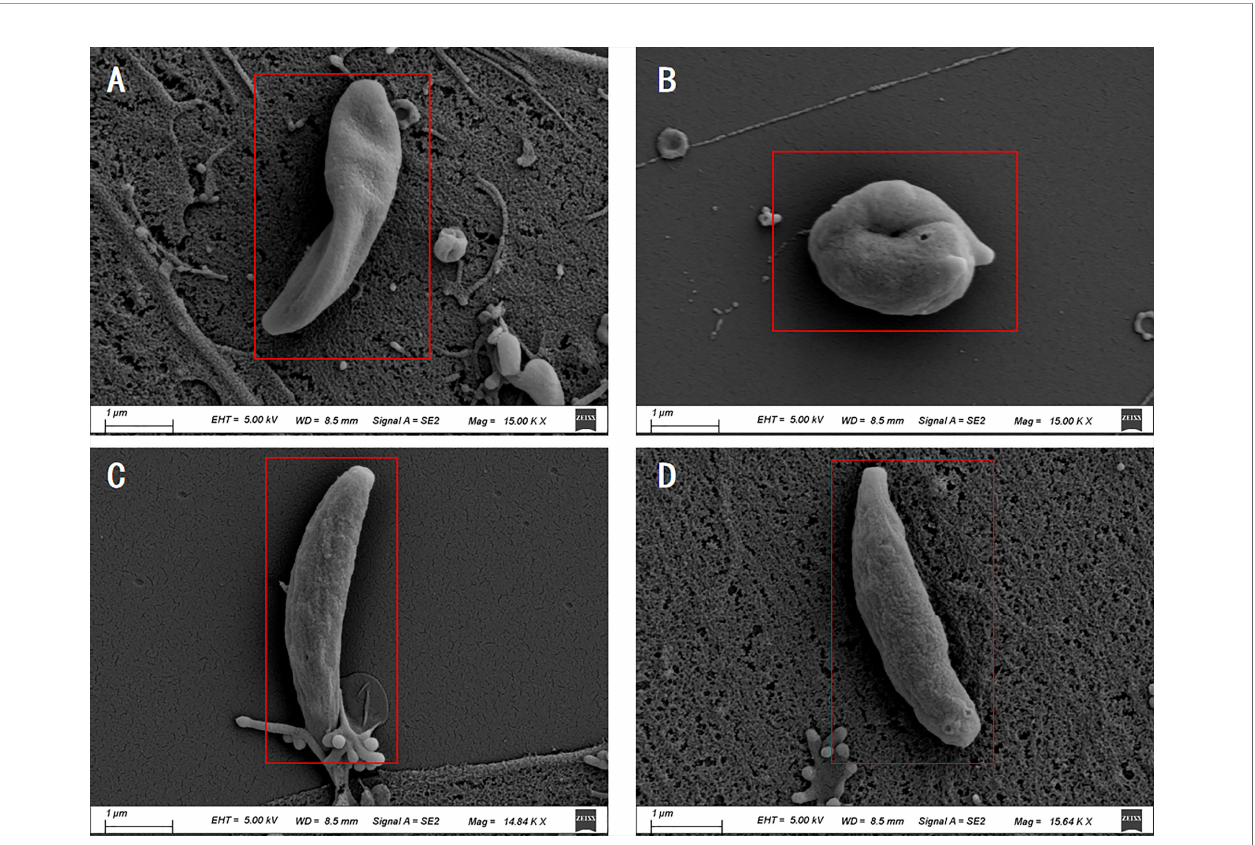
FIGURE 7 | Scanning electron microscopy assay. The T. gondii were treated with 17 m g/ml Ov EO (A) , 17 m g/ml Ca (B) , DMSO (C) or untreated (D) . After treated by Ov EO, the tachyzoites became sunken compared with those untreated tachyzoites. Tachyzoites treated with Ca become curled up. Scale bars: 1 m m.